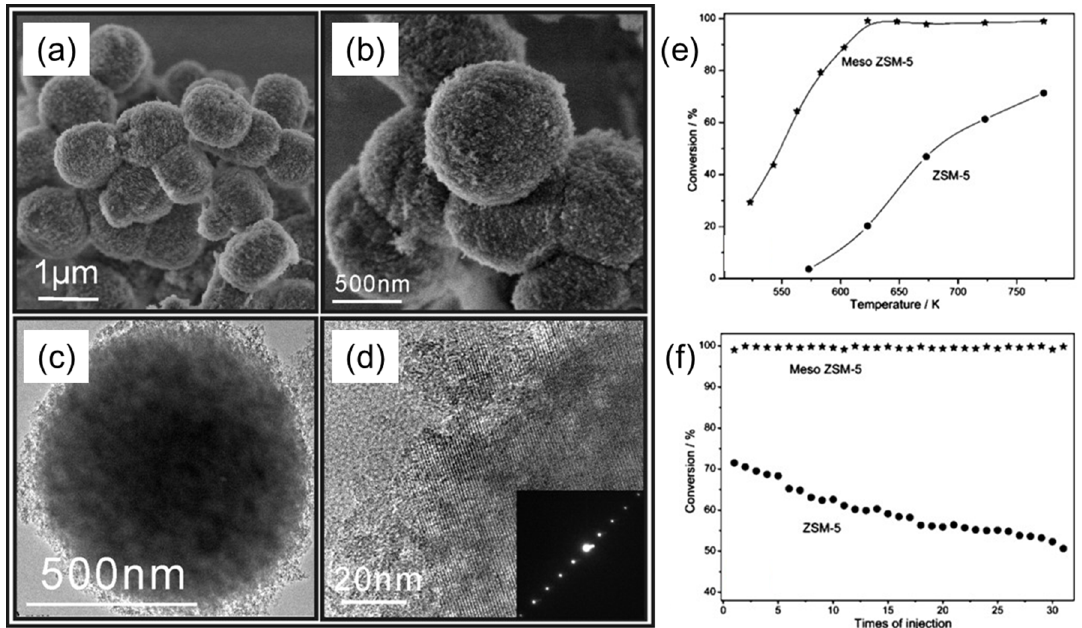
Figure 13. ( a , b ) SEM and ( c , d ) TEM images of meso ZSM-5 particles. © TEM image of a single meso-ZSM-5 particle. ( d ) HR-TEM image taken at the edge of the particle, showing the continuous lattice stripes with an ED pattern (inset). ( e , f ) Catalytic performance of meso-ZSM-5 particles compared to a conventional ZSM-5 catalyst employed in the cracking of TIPB as a probe reaction: ( e ) catalytic activity of meso-ZSM-5 and ZSM-5, determined at different temperatures; ( f ) deactivation behavior at 773 K. Adapted from [34].